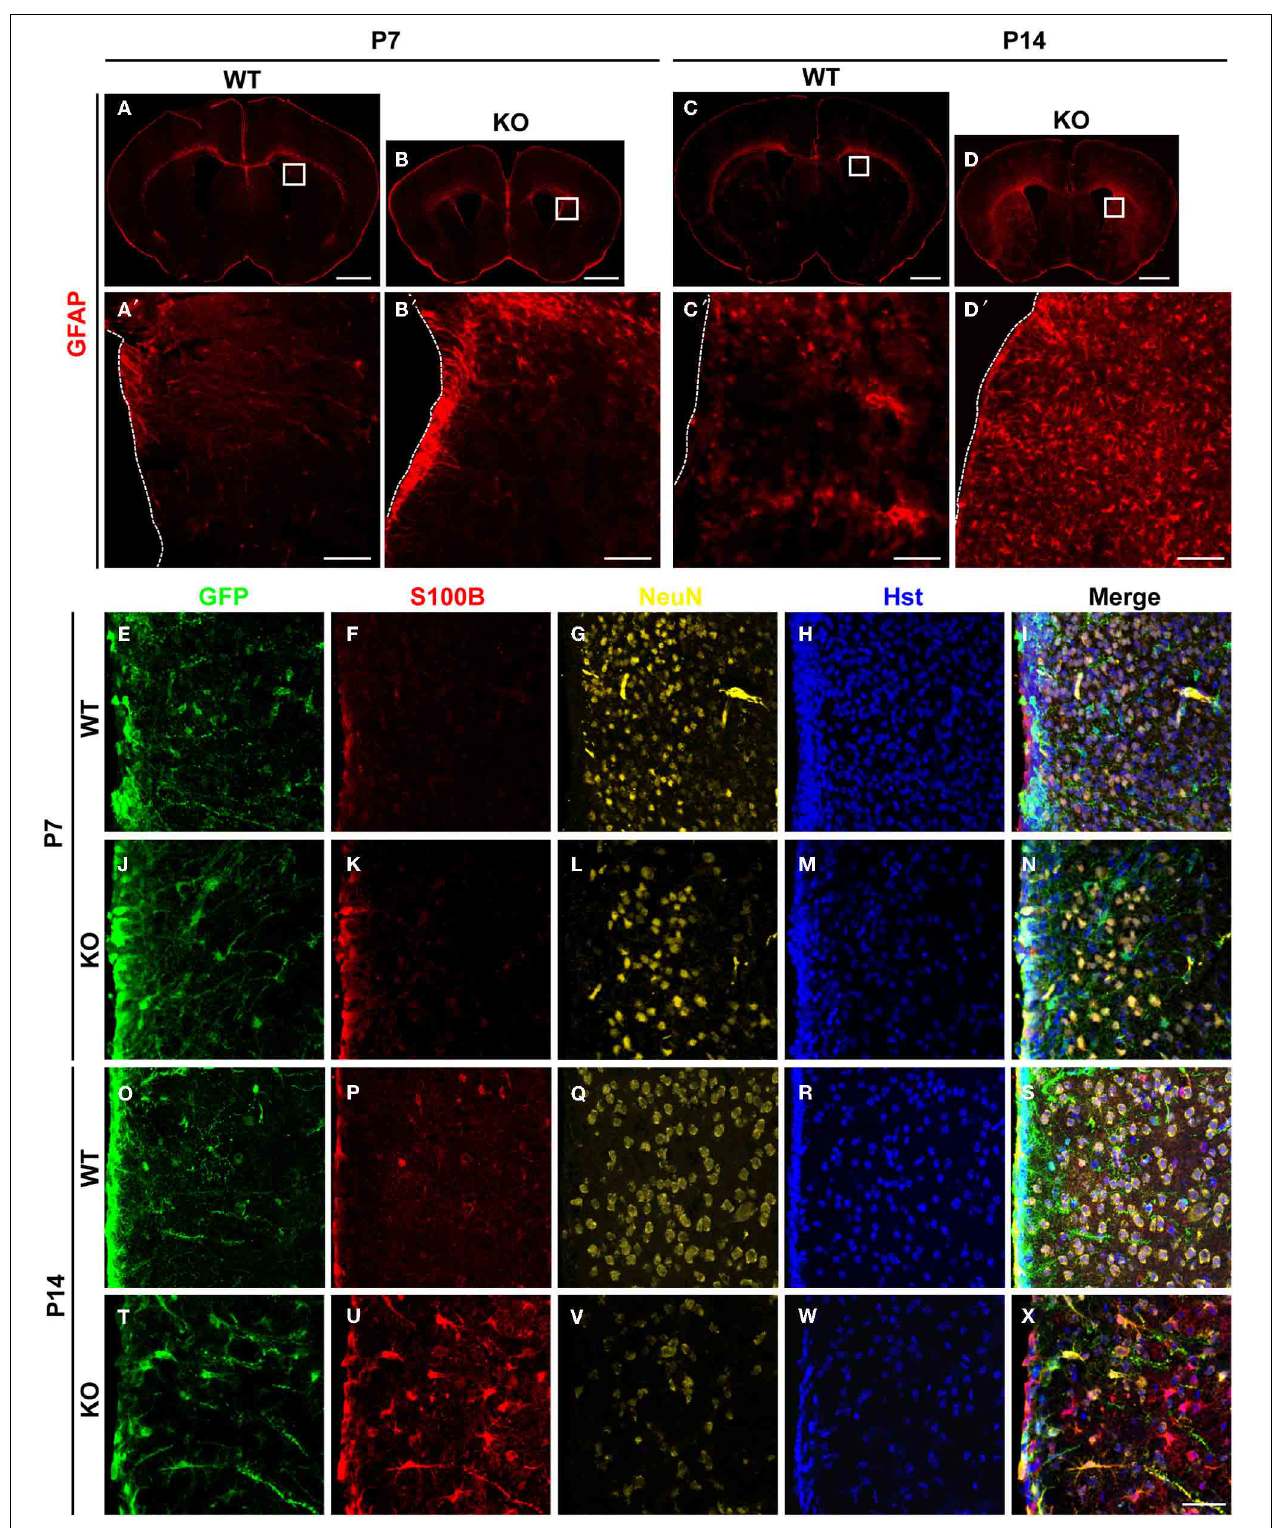
FIGURE 1 | Enhanced postnatal astrogenesis in Tlx − / − brains. (A–D) GFAP expression in brains of Tlx − / − (knockout, KO) and littermate control (wild-type, WT) mice at P7 and P14 ( n = 3). Higher magnification views of the boxed regions are shown on the lower panels (A (cid:2) –D (cid:2) ) . The dotted lines show lateral ventricles(LV). (E–X) Expressionofmarkersforastrocytes(S100B)andneurons